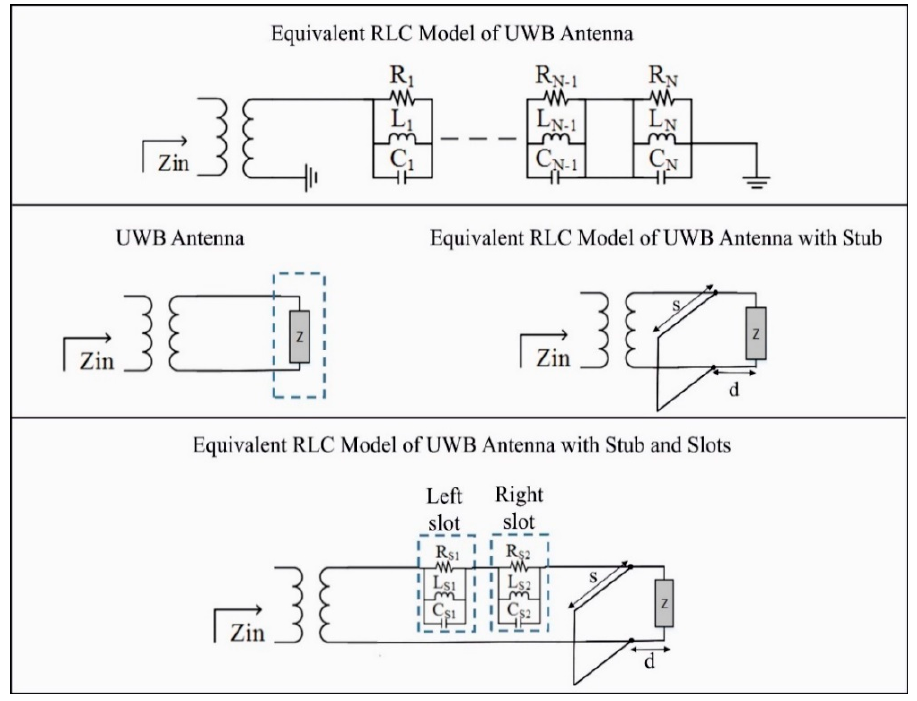
Figure 6. Equivalent circuit model of the proposed antenna.